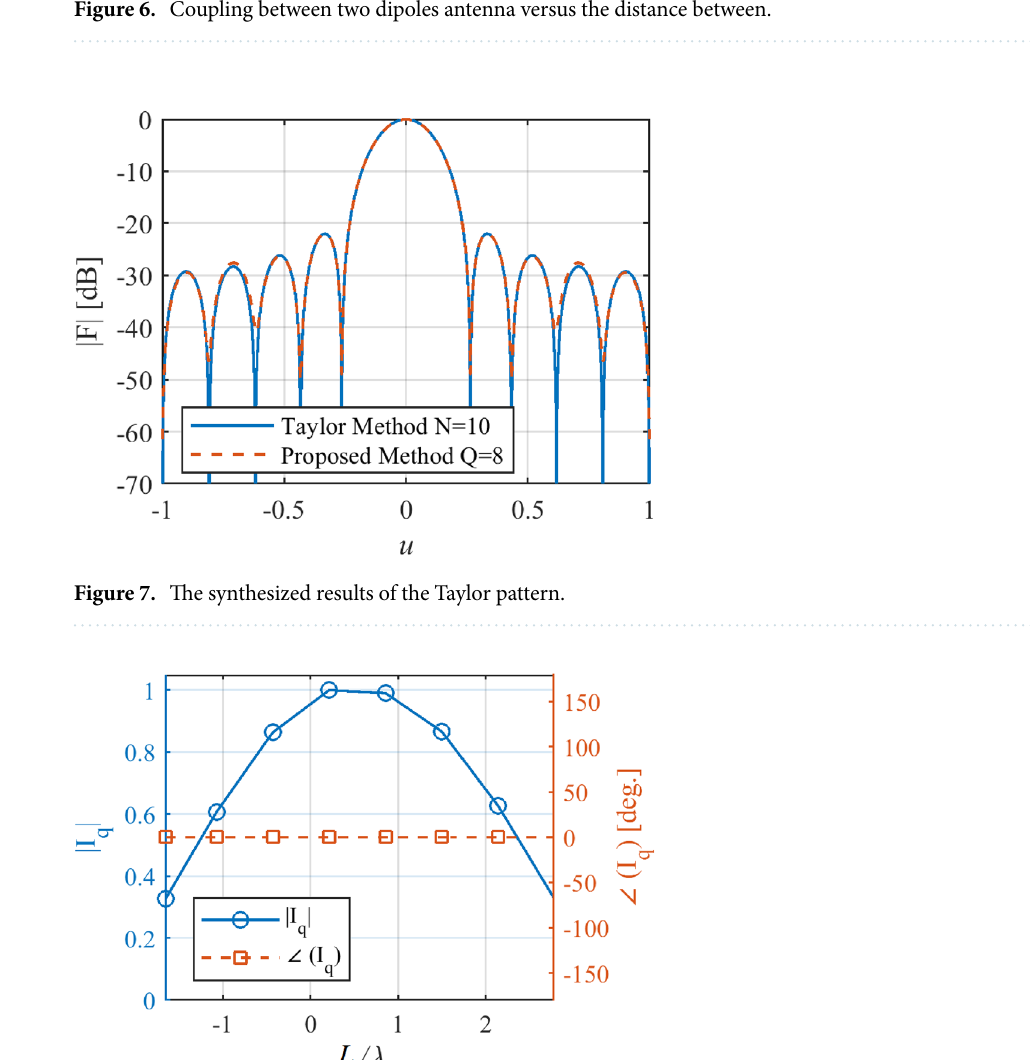
Figure 6. Coupling between two dipoles antenna versus the distance between.